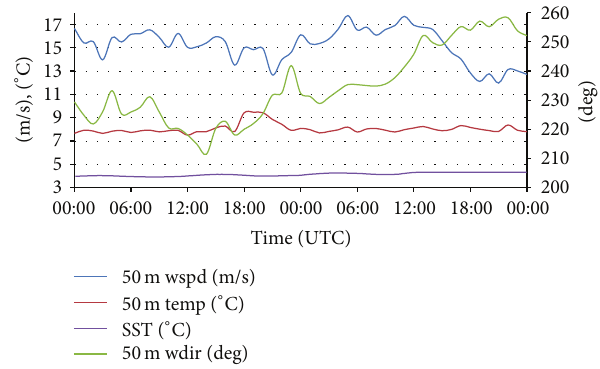
Figure 2: Temporal variation of the sea-surface temperature (SST), air temperature ( ∘ C), wind speed (m/s), and wind direction (degree) at 50 m height, as these were recorded at the FINO1 platform for the stable period 16–18 March 2005 at 00:00 UTC. Temperature and wind speed are represented in the left 𝑦 -axis and the wind direction in the right 𝑦 -axis of the plot.